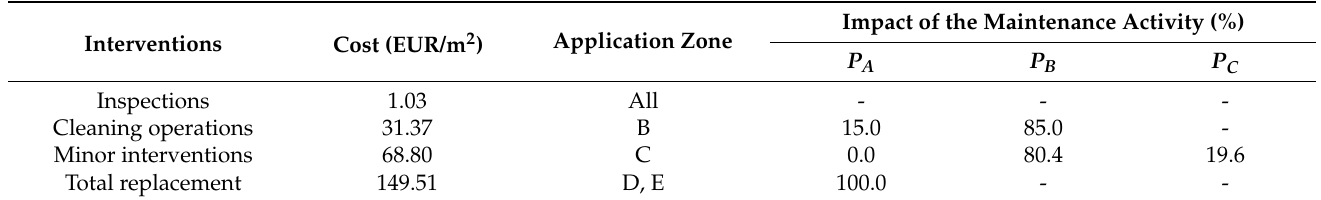
Table 1. Fixed costs, application zones, and impacts of the different maintenance